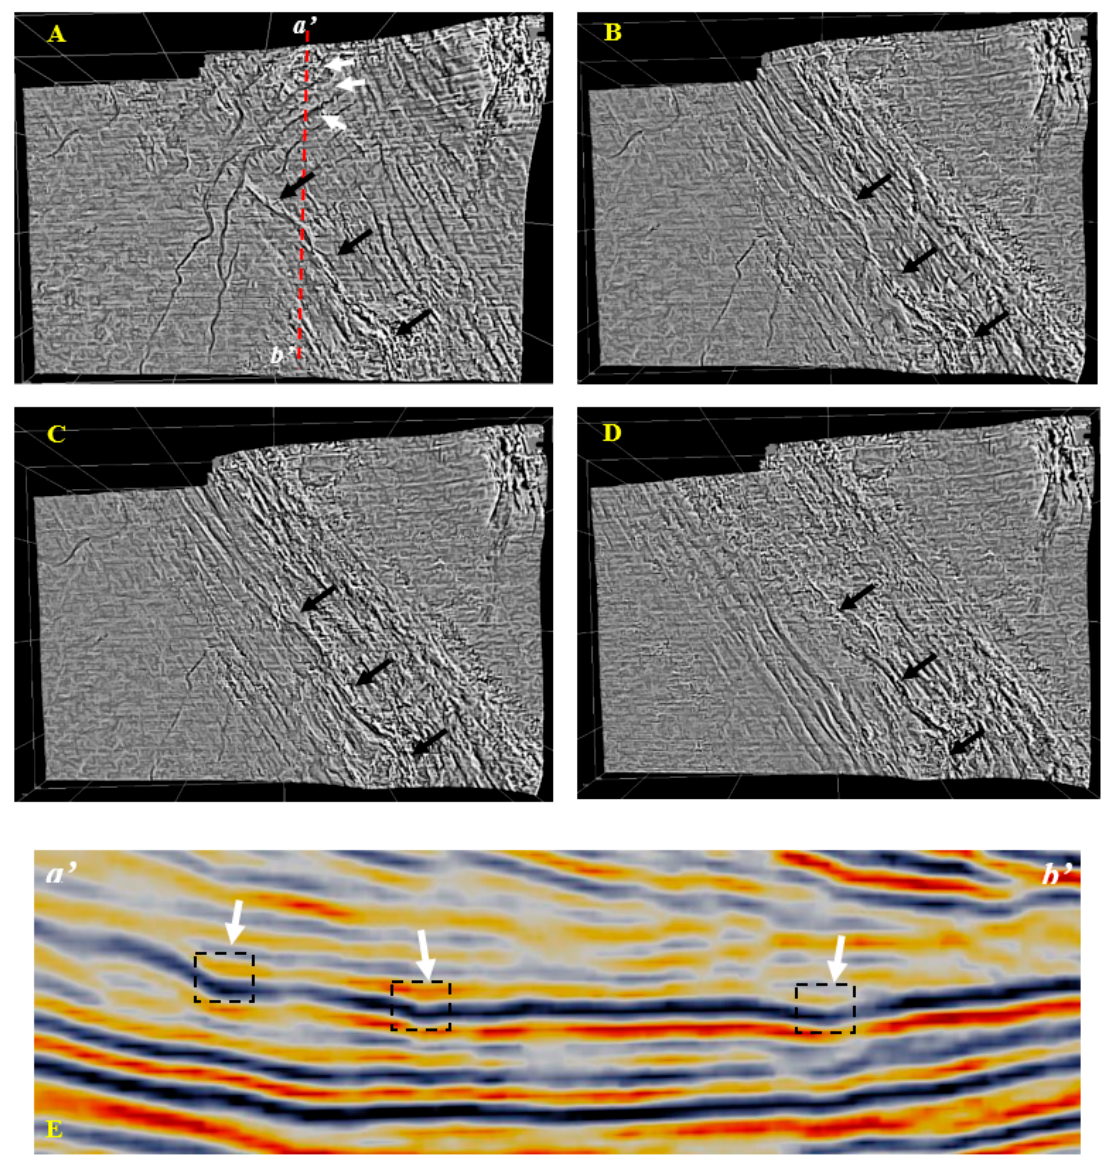
Figure 15. The maximum curvature attributes for each surface. ( A ) MFS1, ( B ) BSFR1, ( C ) CC/SU1, ( D ) MRS1 and ( E ) Seismic section indicates series of minor faults. The black arrows indicate a major fault towards the south while the white arrows indicate a series of minor faults towards the north.